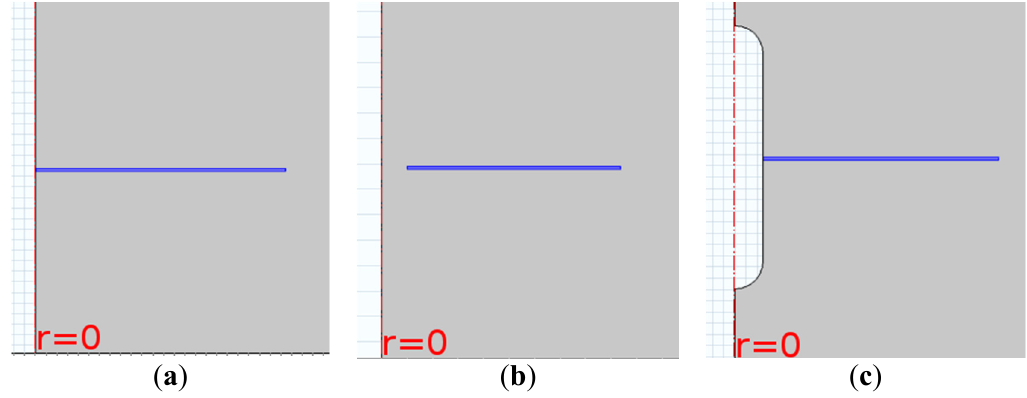
Figure 12. Nacelle/rotor configurations: ( a ) Case 1 full disk; ( b ) Case 2 disk with center-hole; ( c ) Cases? 3–4 disk with